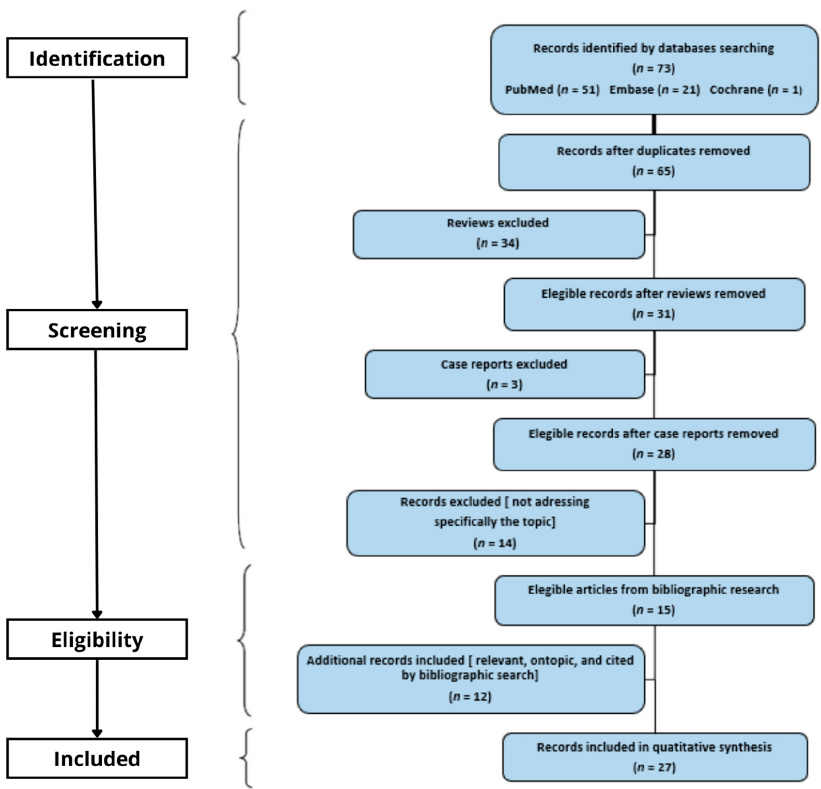
Figure 1. Here we report our Flowchart. The figure displays our flow diagram, i.e., the flow of information through the different phases of our systematic review process, with the records that we found and evaluated in each